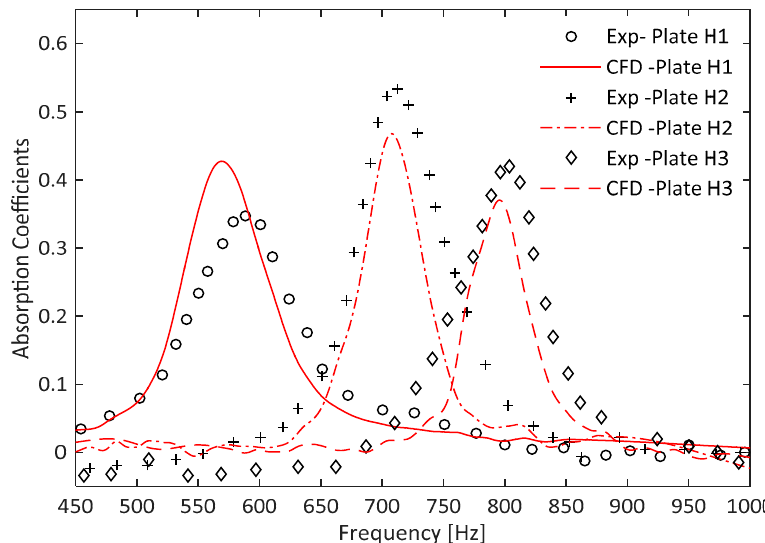
Figure 5. CFD and experimental comparison of absorption coefficients in sound grazing incidence conditions with closed cavity.